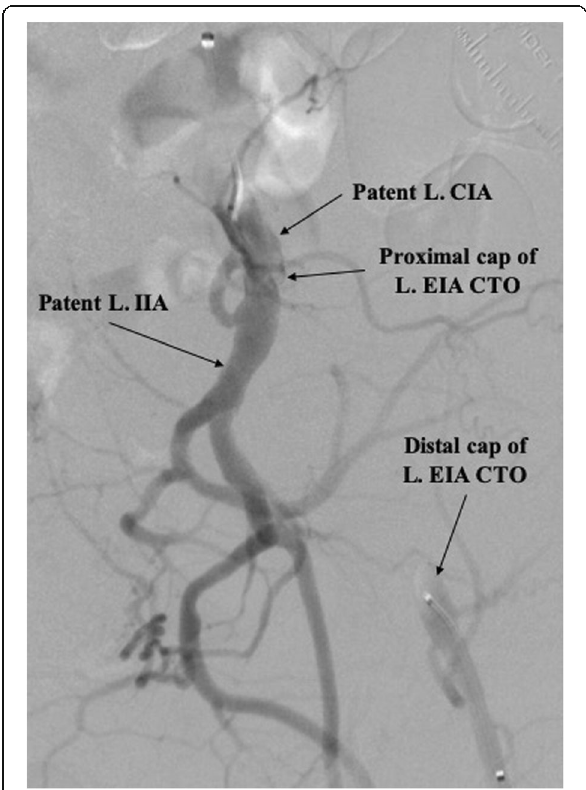
Fig. 2 An angiogram from dual injections demonstrating the proximal and distal caps of a chronic total occlusion (CTO) throughout the entire length of the left external iliac artery (L. EIA). (L. CIA, left common iliac artery; L. IIA, left internal iliac artery)